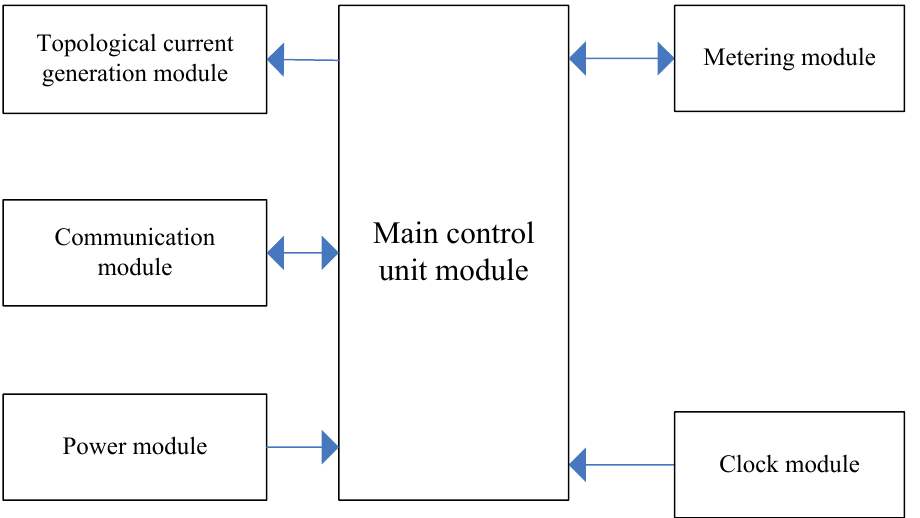
Figure 1. Schematic diagram of control circuit.